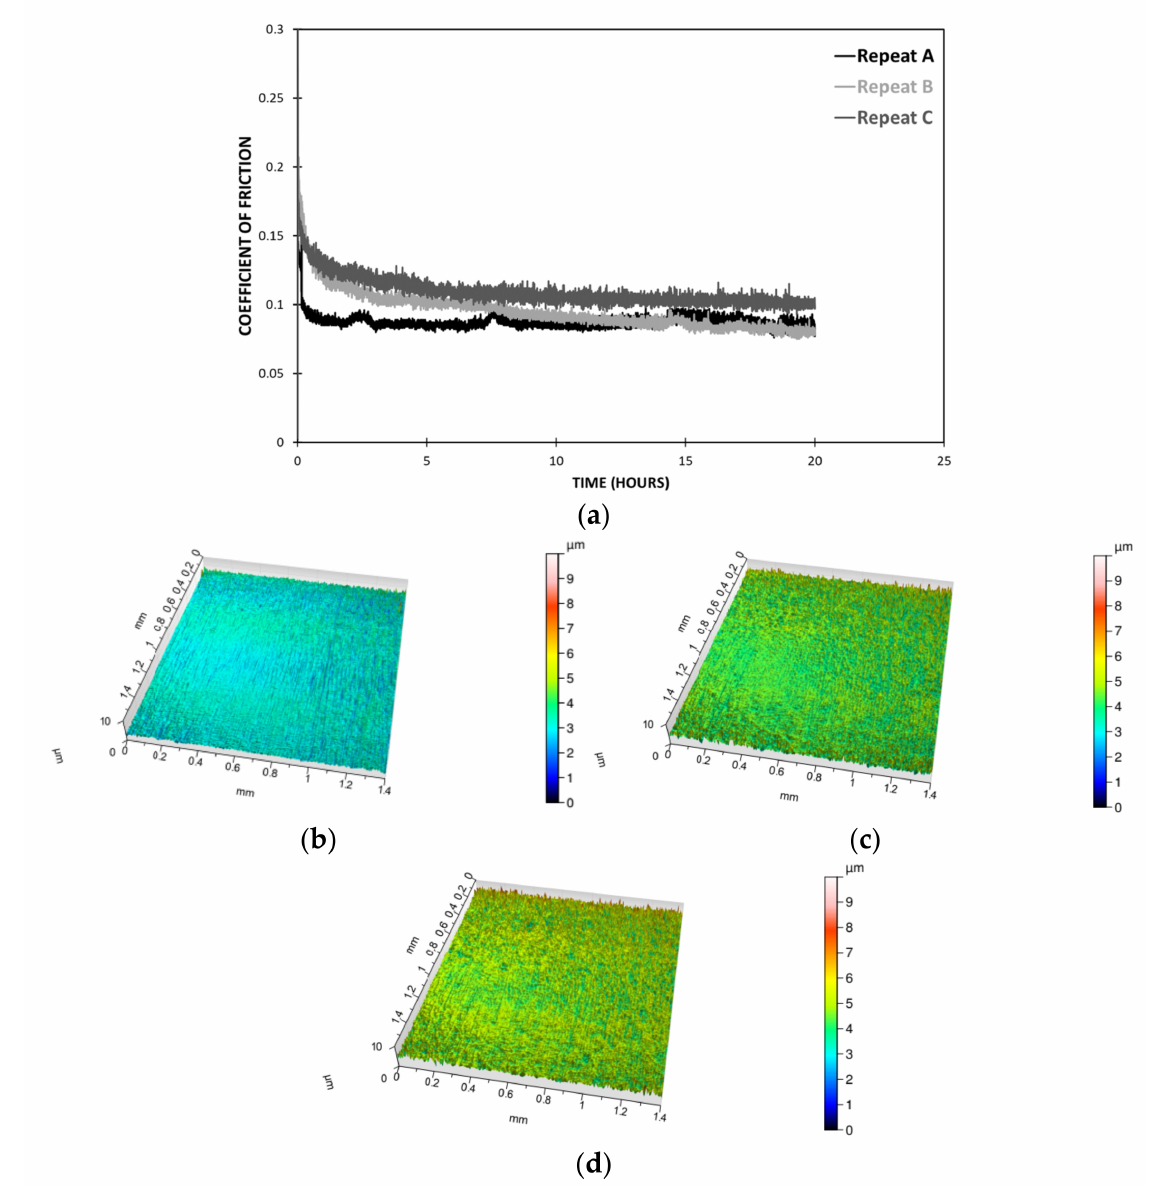
Figure 5. ( a ) Evolution of coefficient of friction of coated Ni variant III rods sliding against anodized Al rod guides under lubricated conditions, triplicate tests. Surface topography of these rods prior to testing, used for ( b ) repeat A, ( c ) repeat B and ( d ) repeat